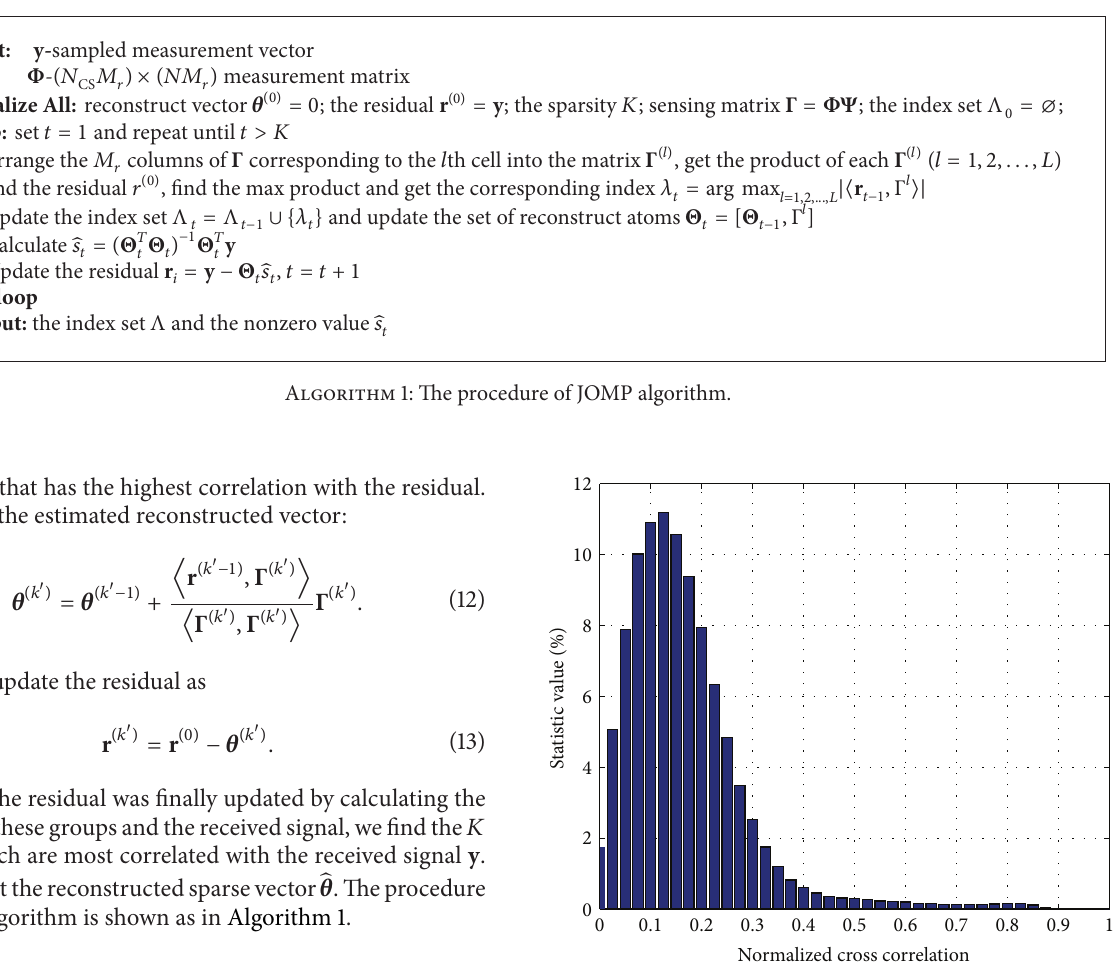
Figure 2: The distribution of normalized cross correlation between the columns of Γ